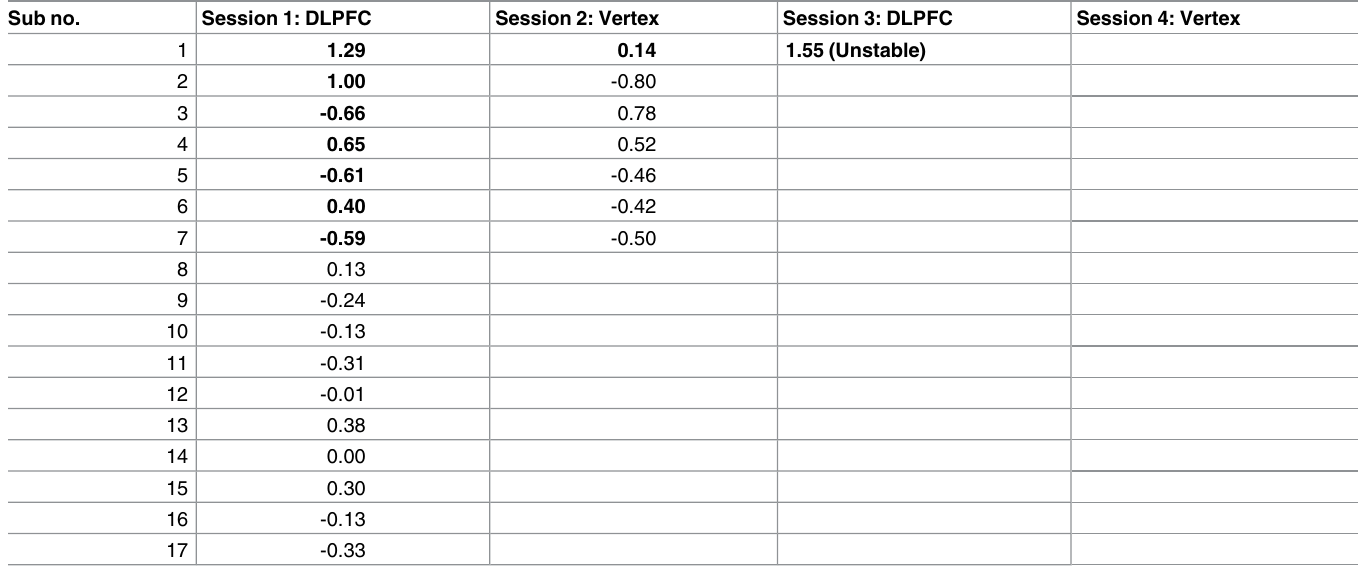
Table 5. Experiment 2 values for meta d’—d’ post TMS minus pre (above threshold results in bold). Sub